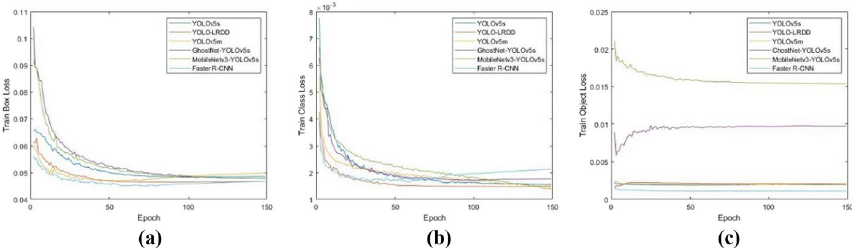
Fig. 7 Comparison of training losses of six types of methods